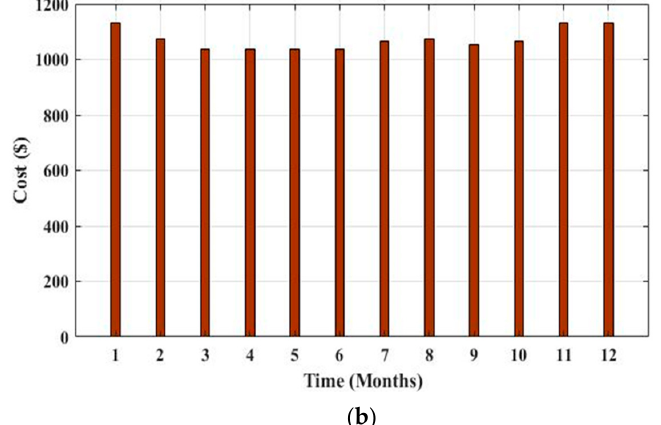
Figure 7. ( a ) EC and ( b ) energy cost of open loop system.